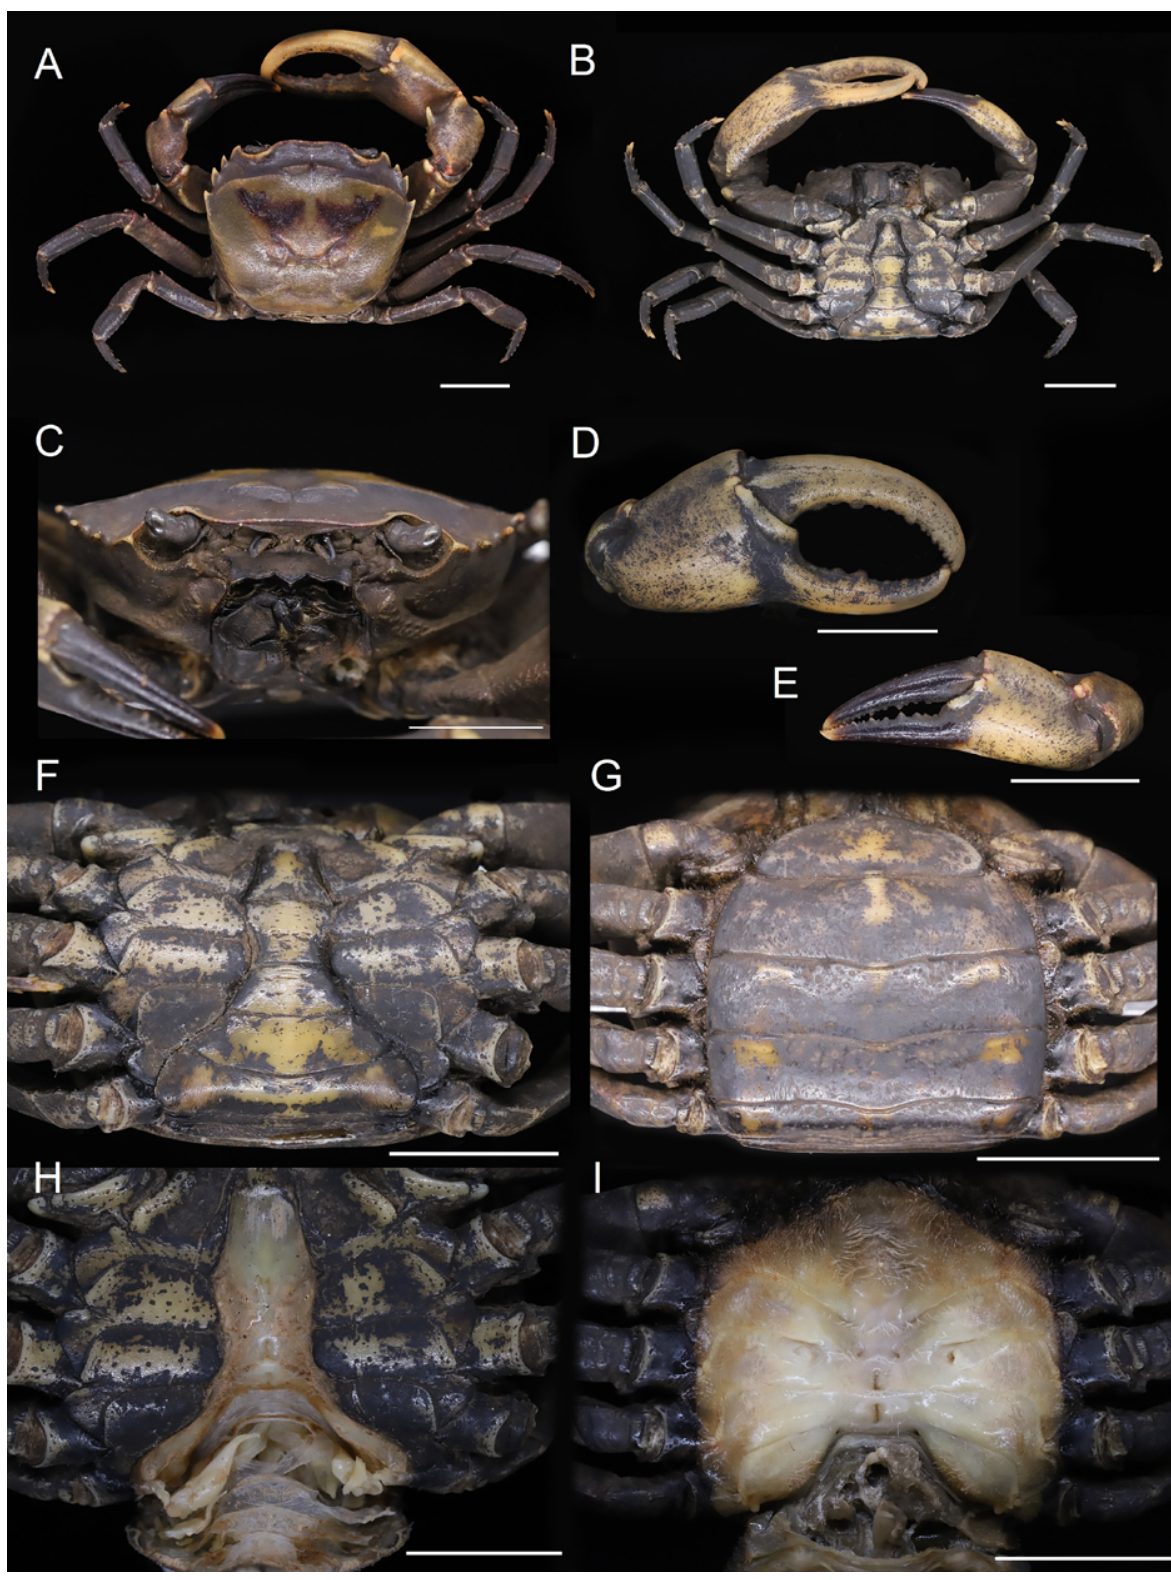
Figure 1. Mekhongthelphusa menglongensis sp. nov., holotype male (35.1 × 30.4 mm) (NNU 16C-MM01) ( A–F, H ); paratype female (34.7 × 28.9 mm) (NNU 16C-MM03), ( G, I ). A , Male dorsal view; B , male ventral view; C , male front view; D , male major cheliped; E , male minor cheliped; F , male pleon; G , female pleon; H , male sterno-pleonal cavity; I , female thoracic sternum and vulvae. Scale bars = 1